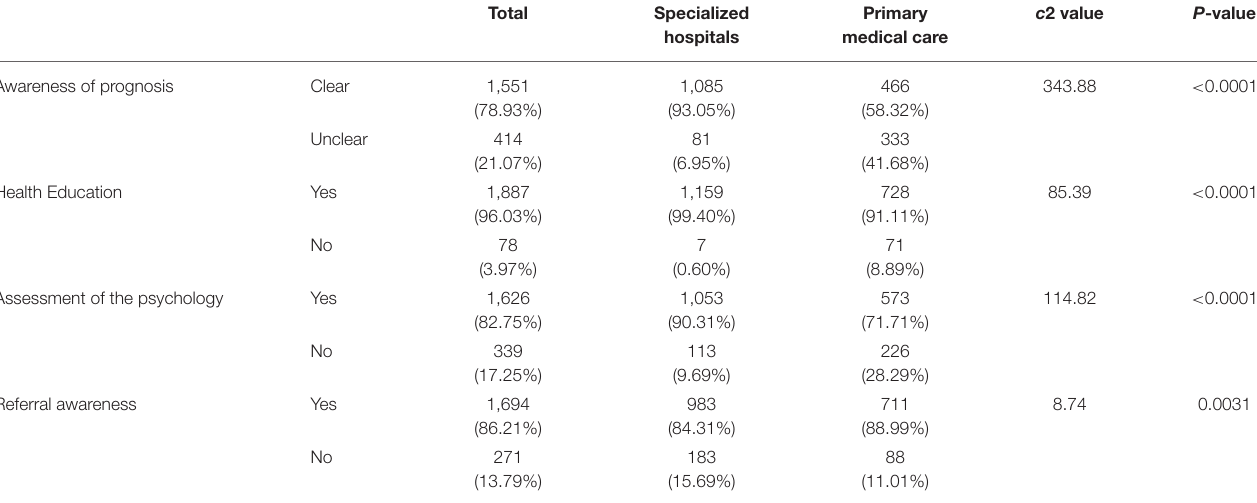
TABLE 5 | The education and management of atypical